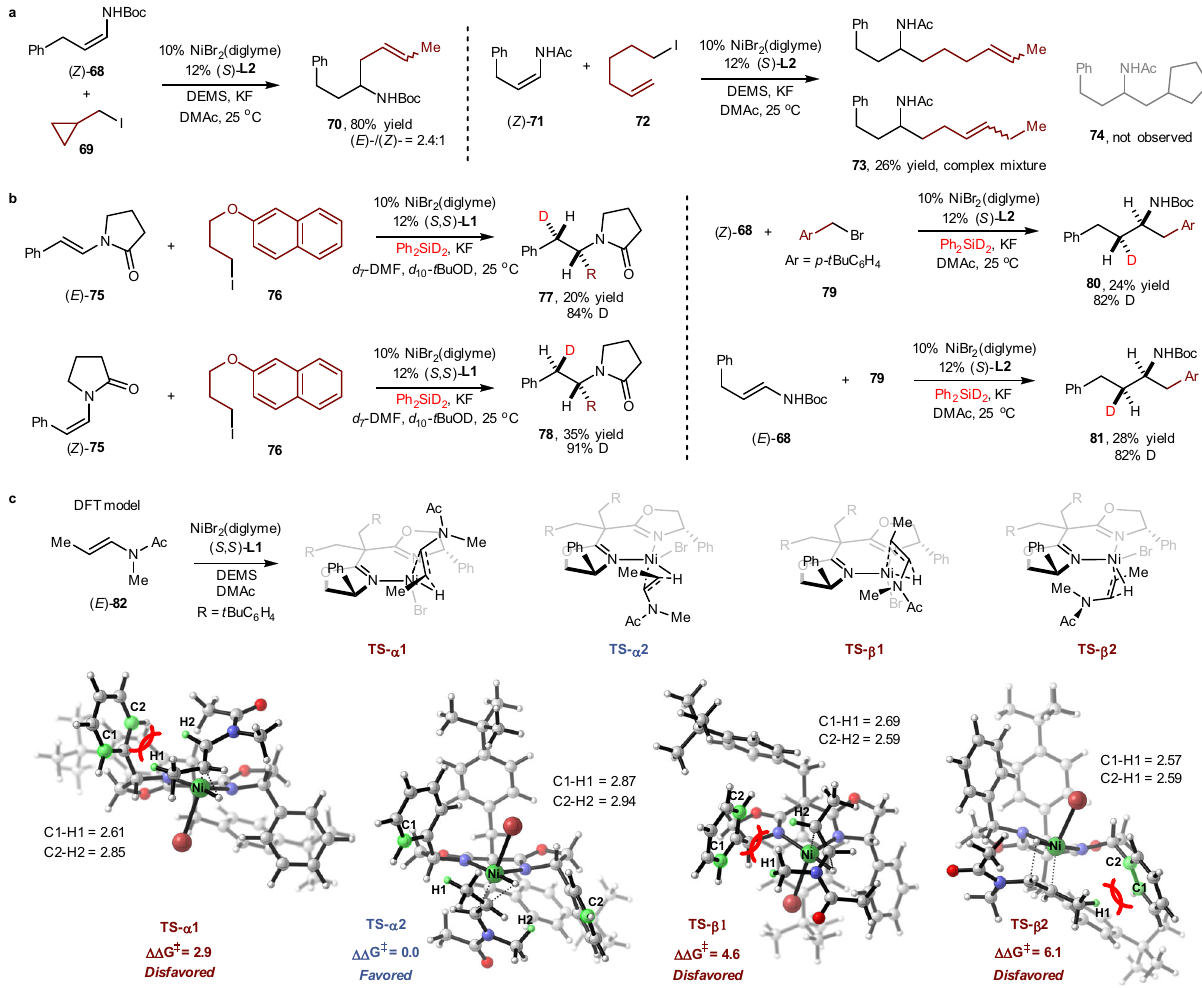
Fig. 4 Mechanistic studies of enamide reductive hydroalkylation. a Radical clock experiments. ( b ) Deuterium-labelling experiments. ( c ) DFT calculations. DFT calculations were also performed at the B3LYP-D3(BJ)/6-311G(d,p)-SDD-SMD(DMA)//B3LYP-D3(BJ)/6-31G*-LANL2DZ-SMD(DMA) level of theory. For more details, see Supplementary Notes 3 and